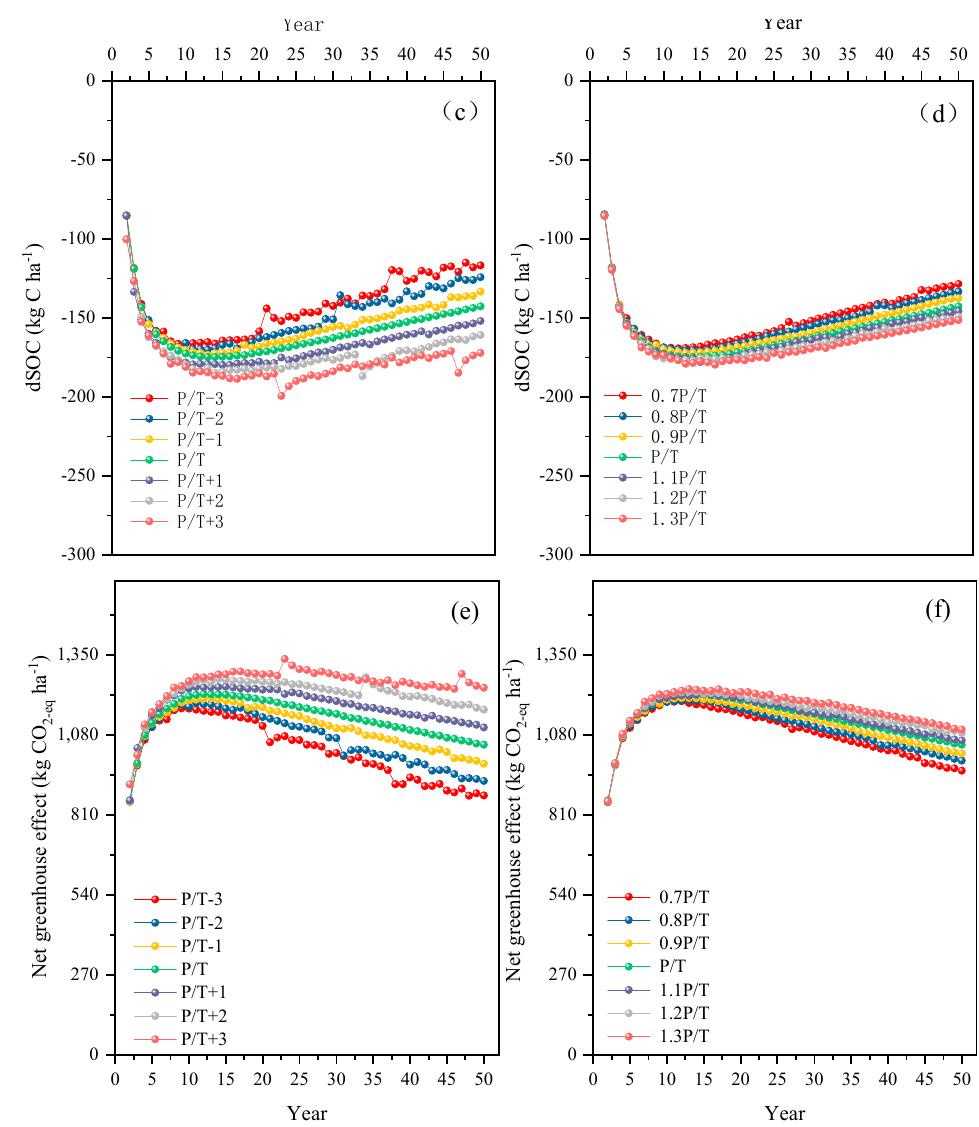
Figure 6. The 50-year effects on N 2 O emissions ( a , b ), SOC loss ( c , d ), and the global warming potential ( e , f ) under temperature change scenarios and precipitation change scenarios. P/T − 3: temperature decreased by 3 ◦ C; P/T − 2, temperature decreased by 2 ◦ C; P/T − 1: temperature decreased by 1 ◦ C; P/T: temperature unchanged; P/T+1: temperature increased by 1 ◦ C; P/T+2: temperature increased by 2 ◦ C; P/T+3: temperature increased by 2 ◦ C; 0.7P/T: precipitation decreased by 30%; 0.8P/T: precipitation decreased by 20%; 0.9P/T: precipitation decreased by 10%; P/T: precipitation unchanged; 1.1P/T: precipitation increased by 10%; 1.2P/T: precipitation increased by 20%; 1.3P/T: precipitation increased by